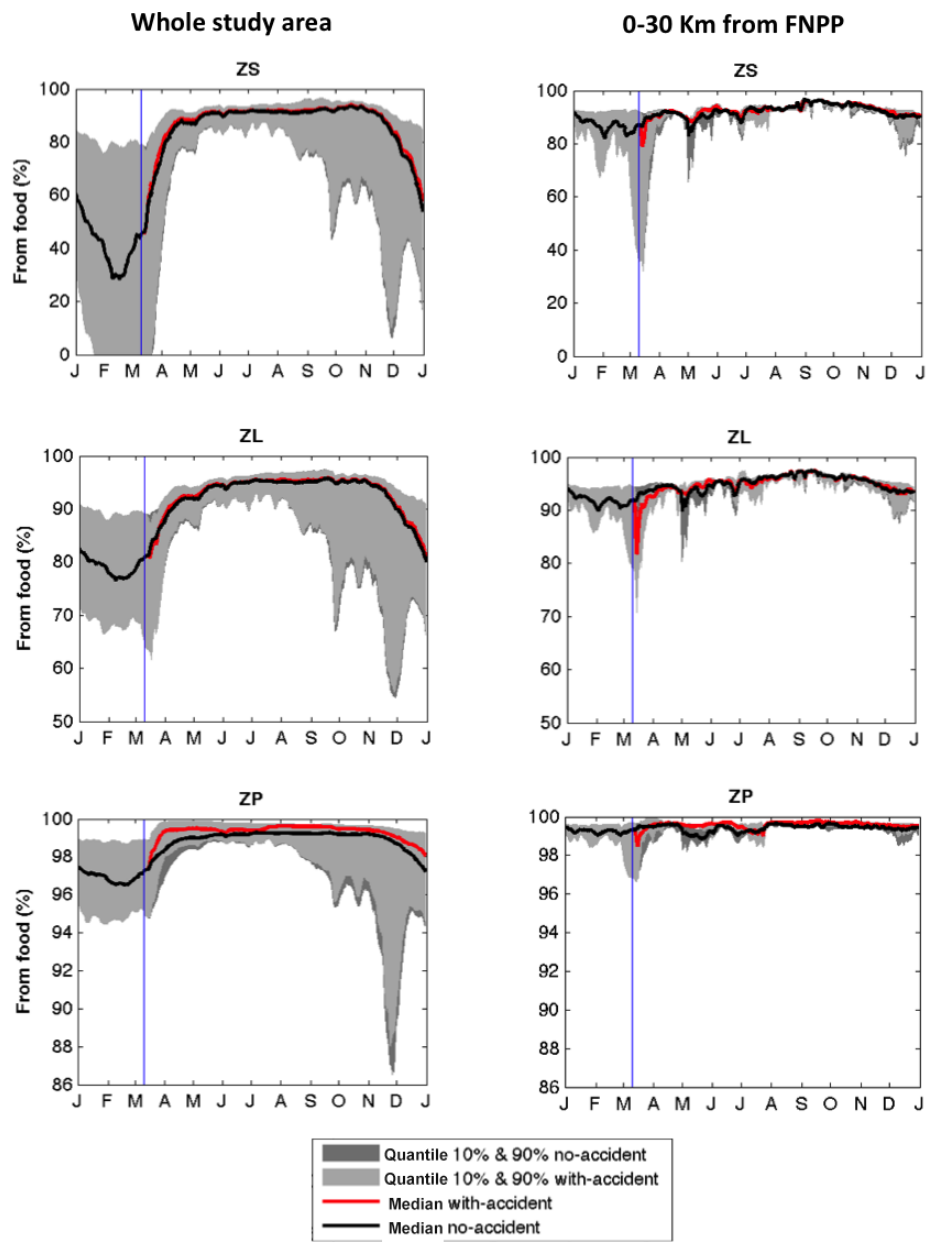
Figure 9. Relative fraction of 137 Cs accumulated from diet for the three groups of zooplankton calculated as the spatial median and quantiles of the whole study area (left) and in the sector located at less than 30km from FNPP (right). The vertical blue line separates the pre- and post-accident